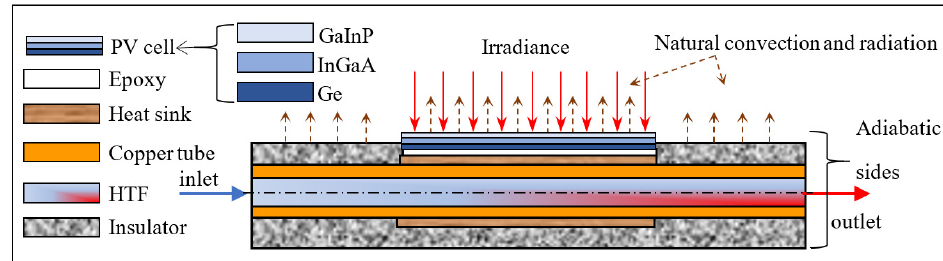
Figure 4. Schematic description of CPVT assembly layers. The steady-state heat conduction within the MJPV assembly to the top surface of the copper pipe is defined by Fourier’s law as follows: